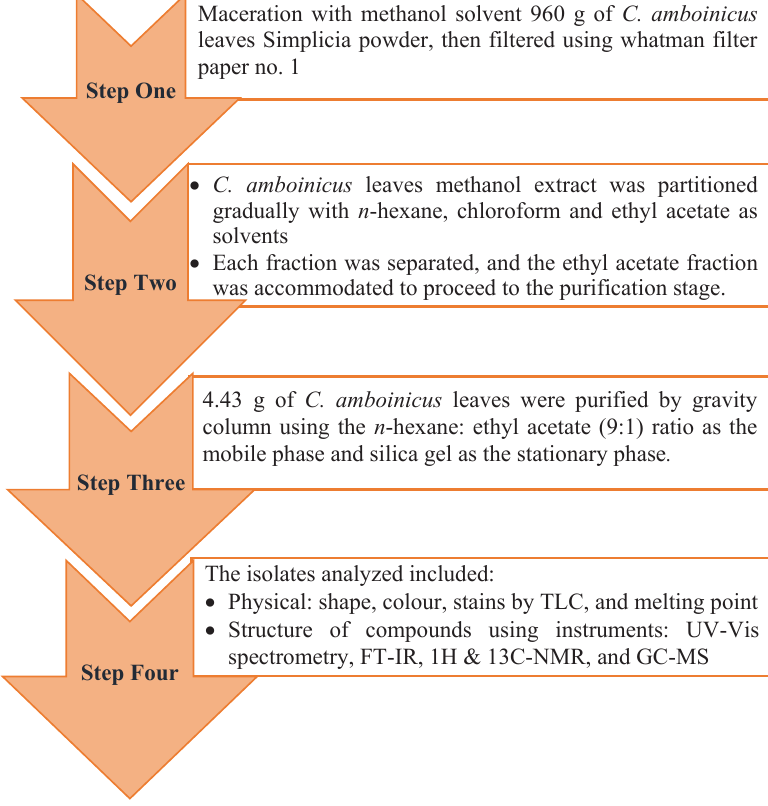
Fig. 1. Isolation scheme secondary metabolite ethyl acetate fraction from C. amboinicus